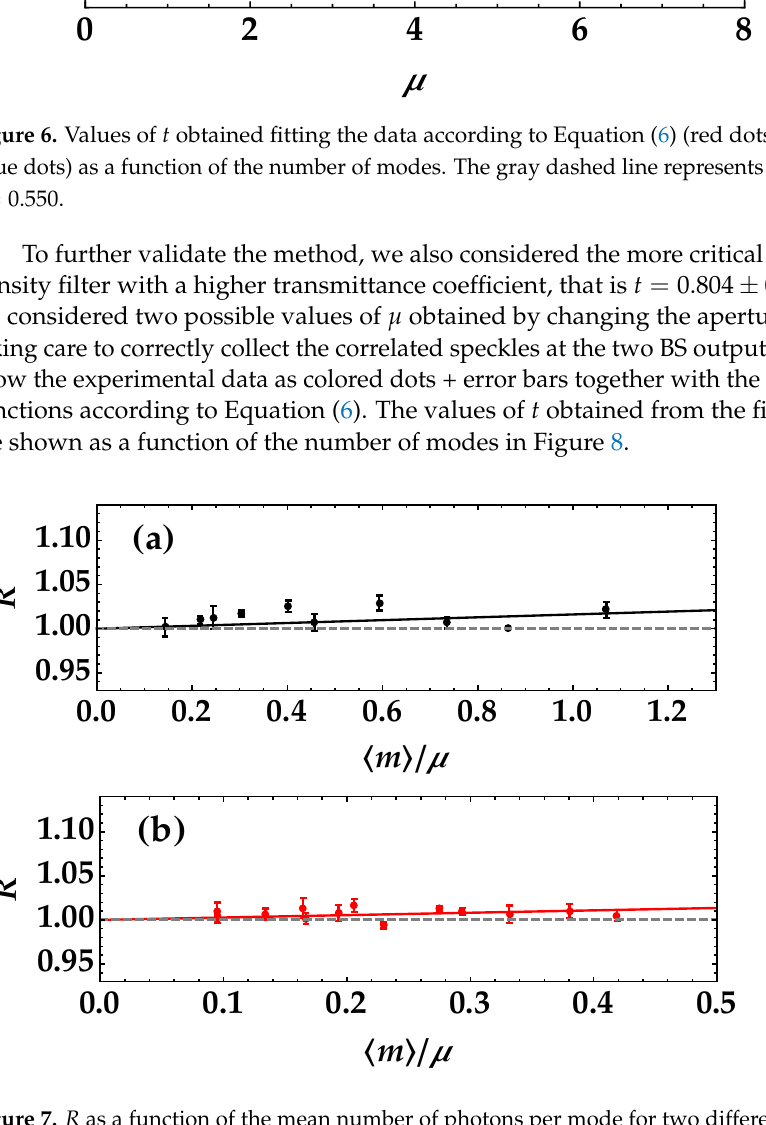
Figure 7. R as a function of the mean number of photons per mode for two different values of µ . The data are shown as colored dots + error bars, while the theoretical curves according to Equation (6) are shown as colored lines. From the fitting procedure, we obtain the value of t . In particular, in Panel ( a ), t = 0.81 ± 0.03 (case µ = 1.05 ± 0.02), and in Panel ( b ), t = 0.78 ± 0.03 (case µ = 3.7 ±